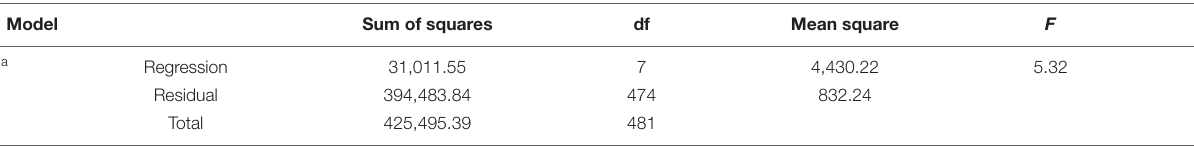
TABLE 6 | ANOVA test for the components of motivation and resilience.